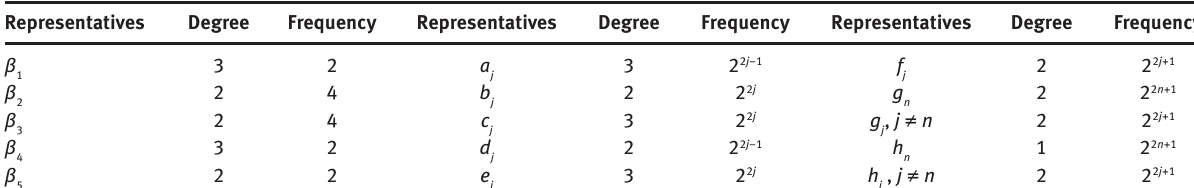
Table 1: Representatives, degrees, and frequencies used.